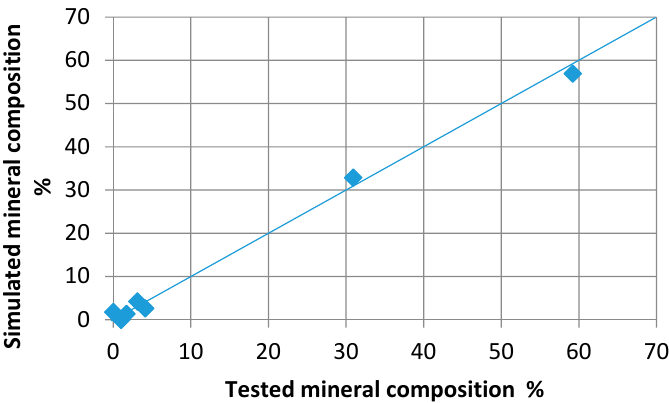
Figure 7. Comparison of the predicted and experimentally determined volume fraction of the minerals present in sandstone.